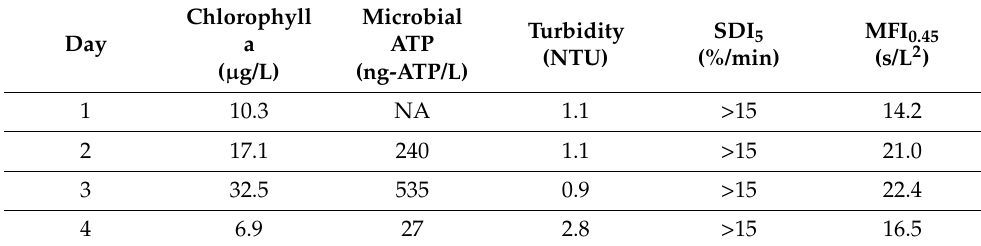
Table 3. Seawater properties in the